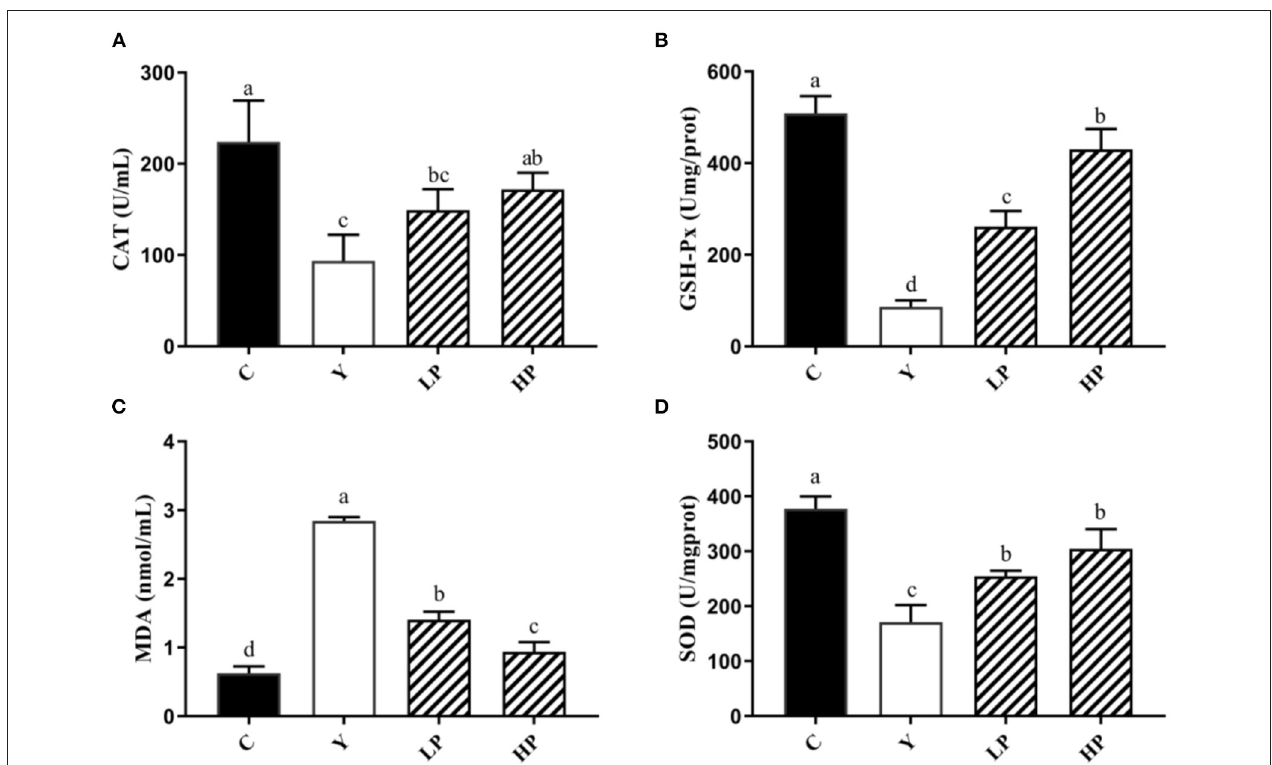
FIGURE 5 | Effects of OP on the contents of CAT (A) , GSH-Px (B) , MDA (C) , and SOD (D) in liver of oxidative injured mice. Different letters in the figure represent significant differences ( P < 0.05). C: the normal group; Y: the Cy-induced group; LP: Cy + 200 mg/kg OP; HP: Cy + 400 mg/kg